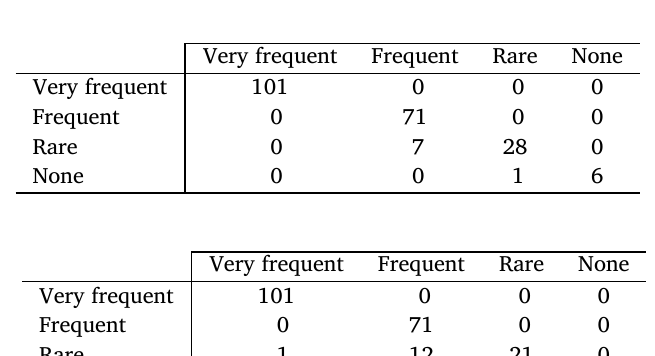
Confusion Matrix of WAODE classifier for Cysouw’s